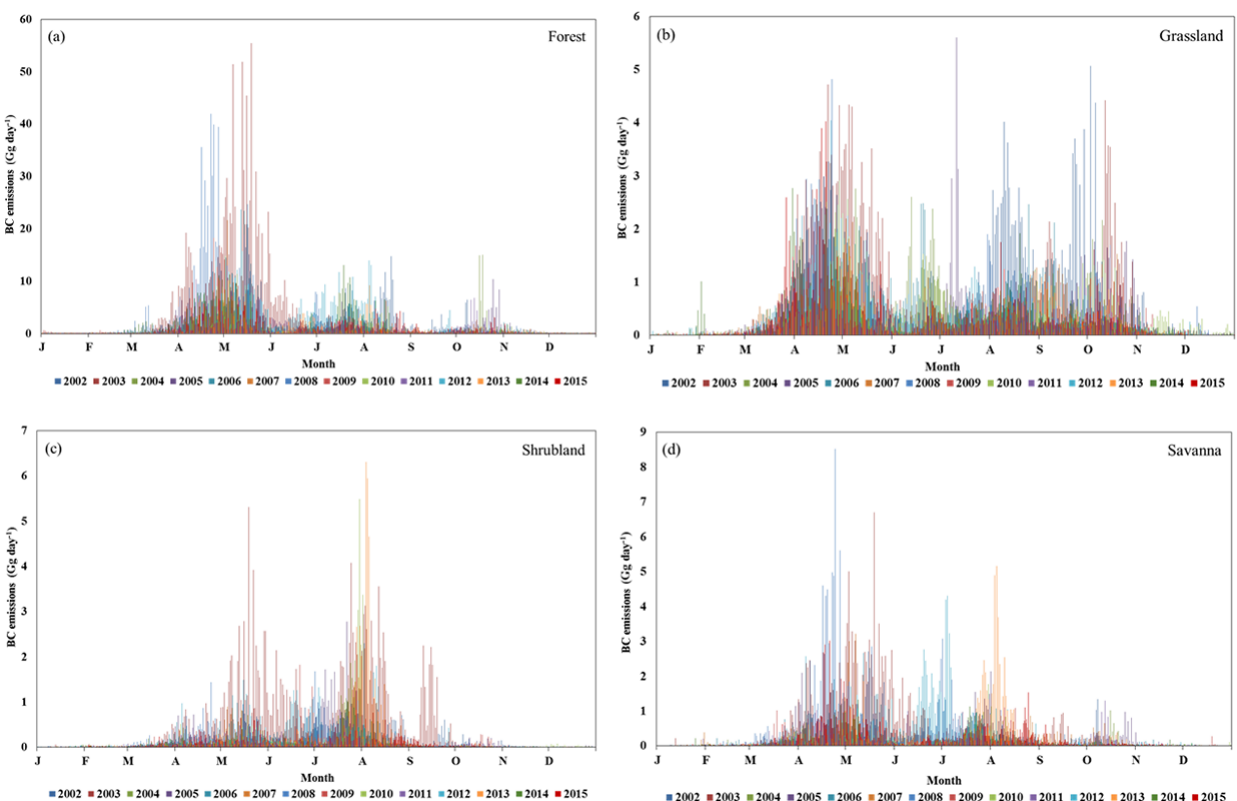
Figure 8. Daily BC emissions in different land cover types in northern Eurasia from 2002 to 2015. Note the differences in the y axis scales of BC emissions from fires in different land cover